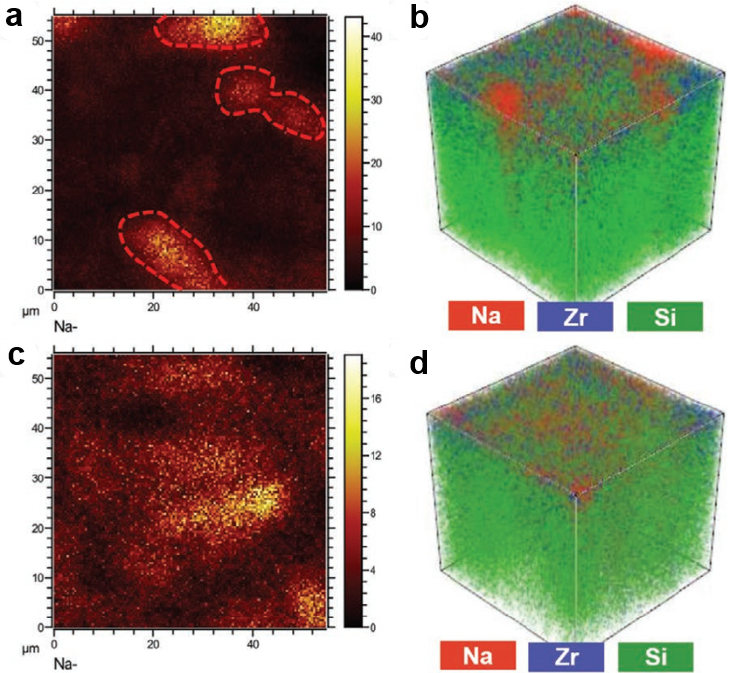
Figure 7. ( a ) Mapping of Na species and ( b ) overlay depth profile of Na, Zr, and Si on TS1300-15/1200 after cycling; ( c ) mapping of Na species and ( d ) overlay depth profile of Na, Zr, and Si on NS1250 after cycling, reproduced with permission from Reference [121] Copyright 2021, Elsevier.